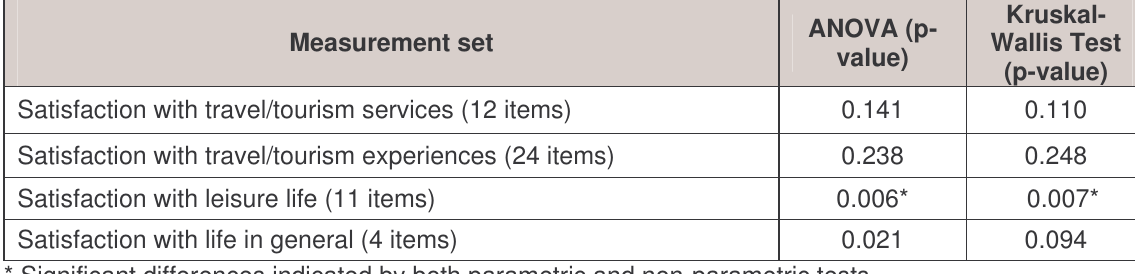
Table 8: Significance testing of the overall mean scores for satisfaction of respondents